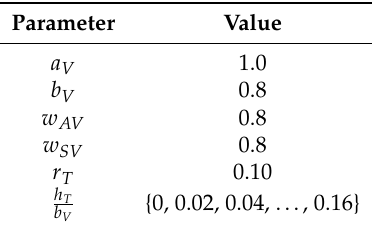
Table 1. Table of geometric parameters used in the idealized numerical model. The height of trabeculae, h T , were varied for numerical